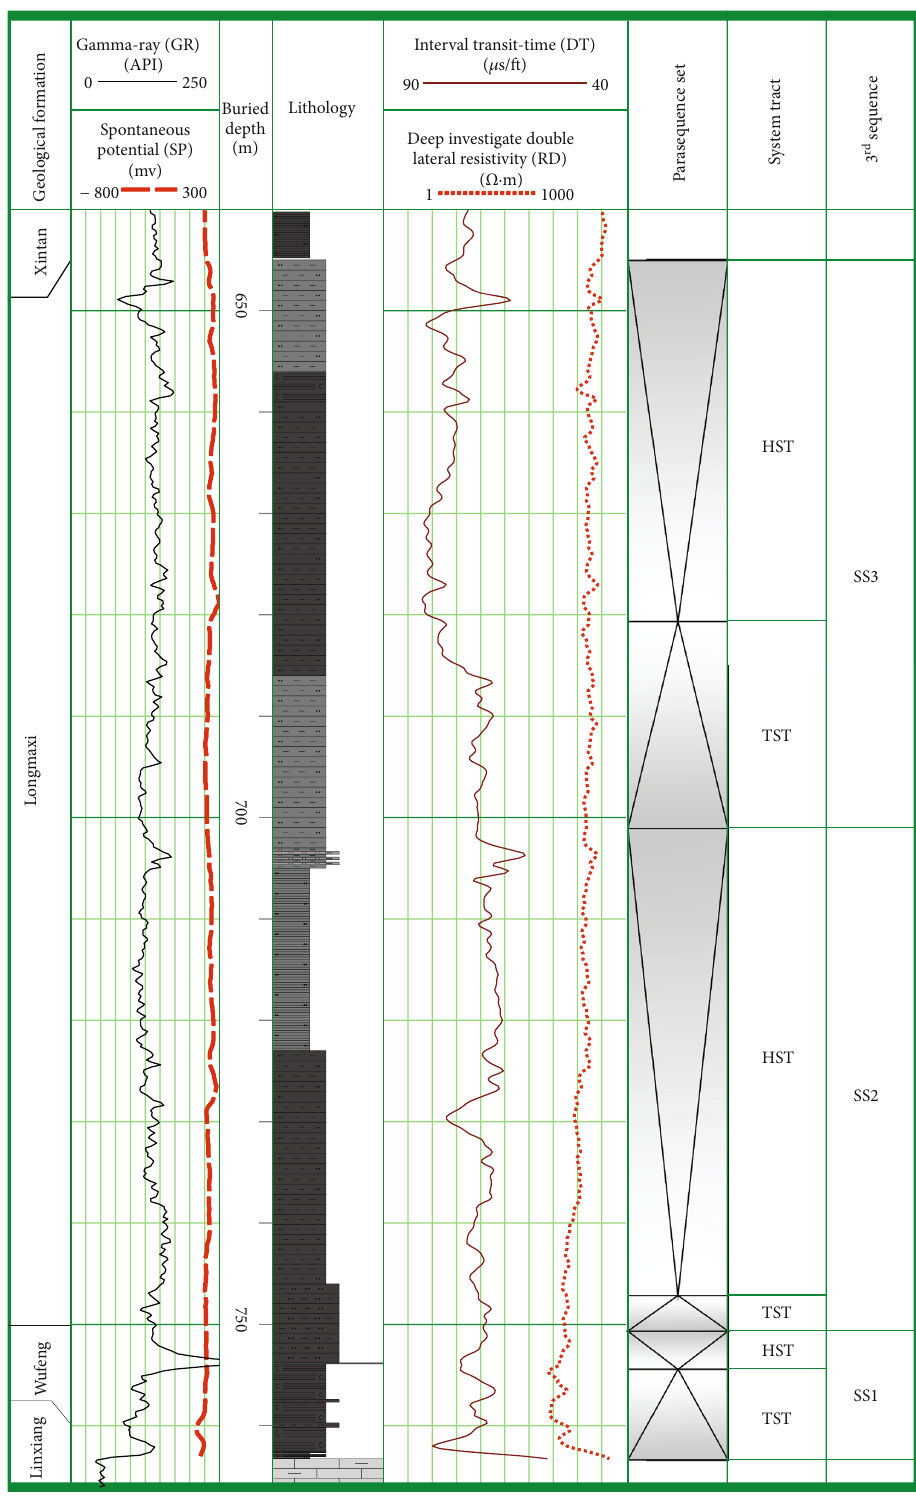
Figure 2: Stratigraphic correlation diagram and vertical variations in the sedimentary sequence of the WL shale in Well-YC4. TST: transgressive system tract; HST: high-stand system